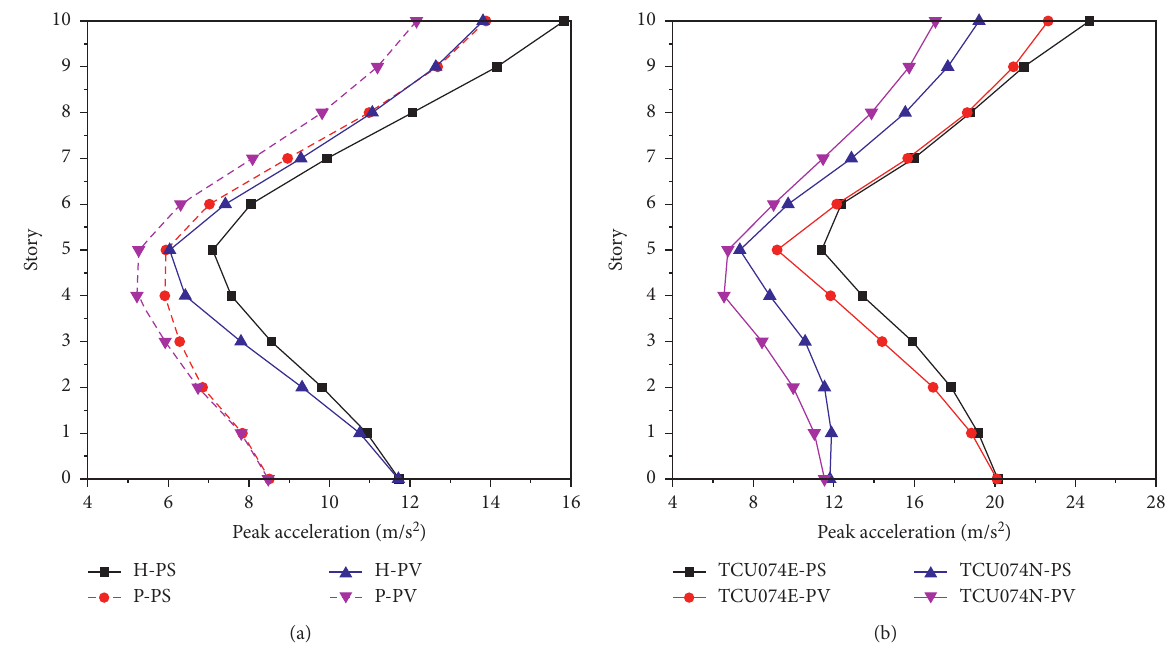
Figure 18: (a) The average peak acceleration of the structure under the horizontal component and parallel component of near-fault ground motion; (b) the peak acceleration of the structure under the ground motion of TCU074. Note . H and P are the horizontal and parallel components of near-fault ground motions,